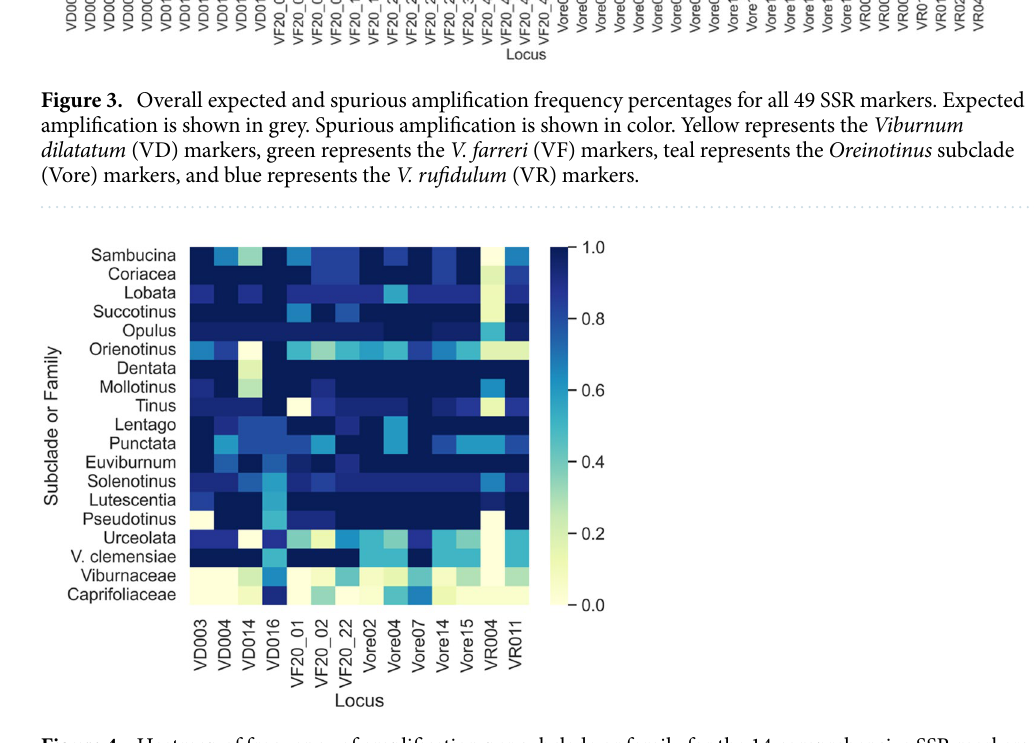
Figure 4. Heatmap of frequency of amplification per subclade or family for the 14 comprehensive SSR markers. The darker the square, the greater the amplification frequency was for the group of